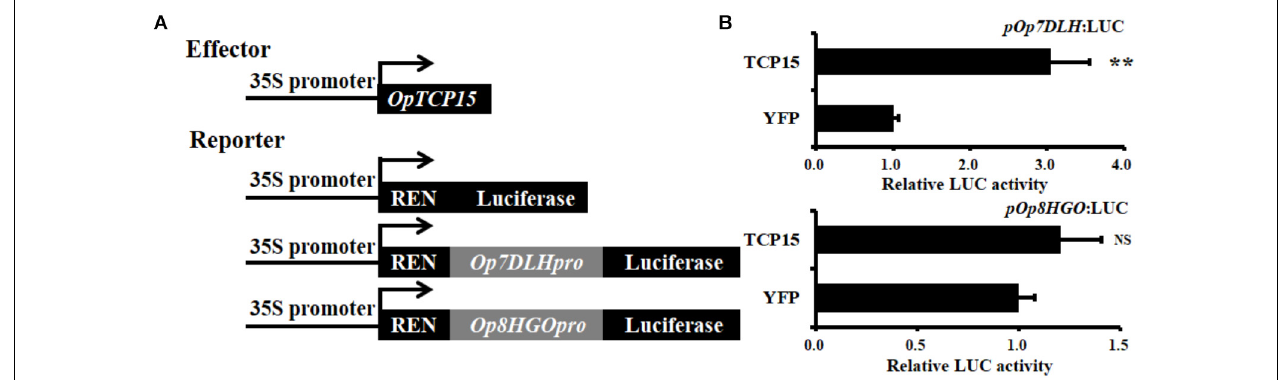
FIGURE 7 | (A) Schematic diagrams of the effector and reporter plasmids used in Dual-LUC assay. (B) Dual-LUC assay in N. benthamiana leaf cells using the constructs shown in panel (A) . The relative LUC activity was normalized to that of the reference Renilla (REN) luciferase. Error bars indicate the SD ( n = 3). Student’s t -test: ** p < 0.01; NS, no significance; Dual-LUC, dual-luciferase